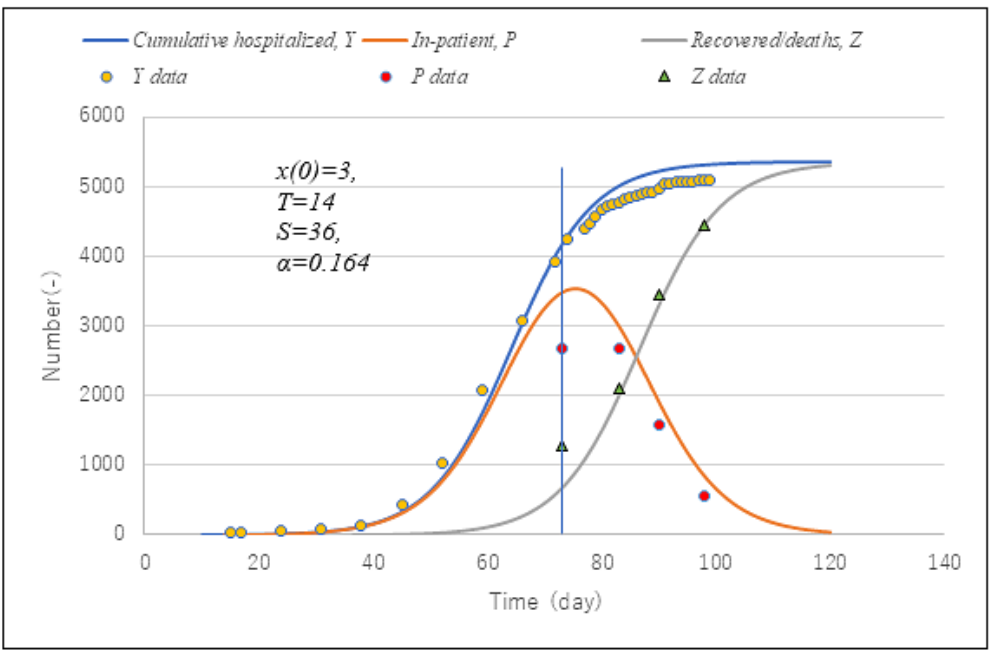
Figure 3. Comparison of simulation results with data in the entire period of the first wave of COVID-19 in Tokyo. Axis represents the number of cumulative hospitalized cases (Y), the number of inpatients (P), and the number of recovered/deaths (Z). Solid lines represent simulations by model PART1. Dotted points show data observed in Tokyo,